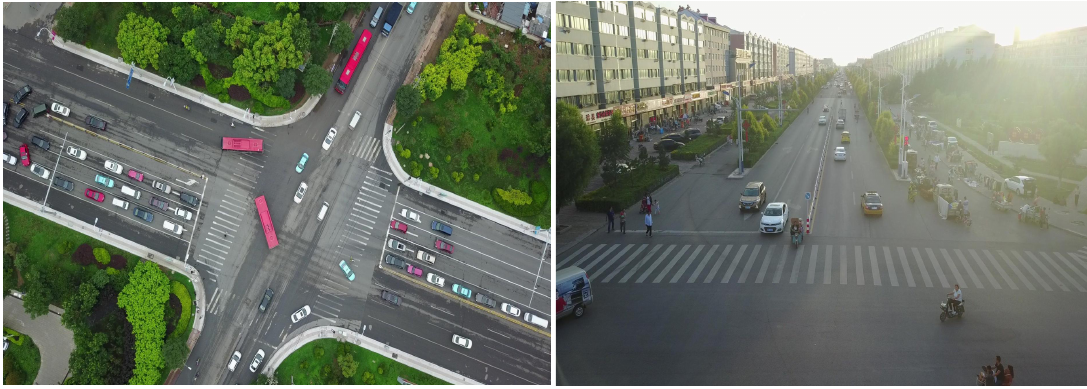
Figure 5. Some example images of the